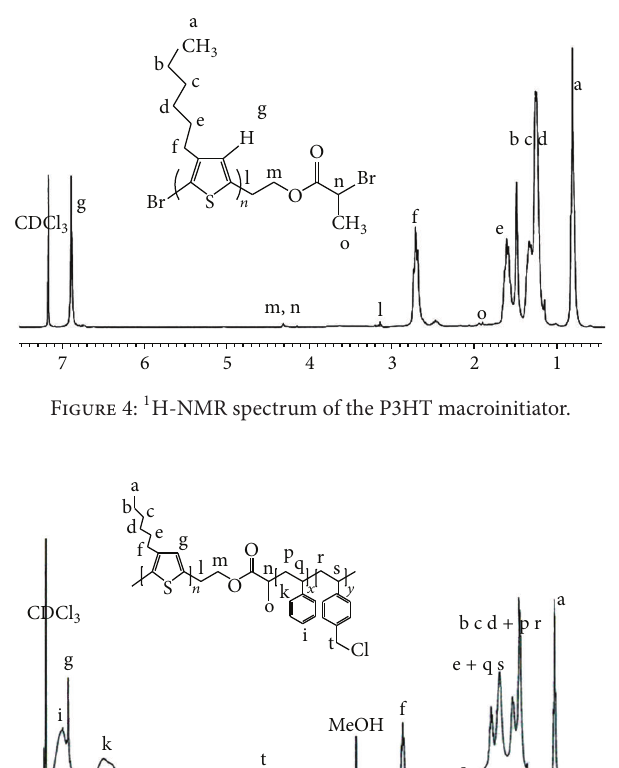
monomer peaks at 1.9, 3.2 and 4.3 ppm that represent the pro-